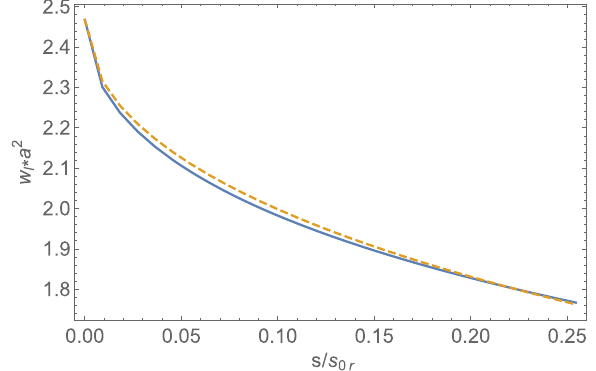
FIG. 3. Longitudinal wake on axis for the RadiaBeam/LCLS dechirper nominal parameters, comparing the numerical inverse Fourier transform of the general impedance equation, Eq. (10) (blue curve), with the approximation, Eq. (15) (the dashes). The ¼ 190 μ m. scale factor s 0 r